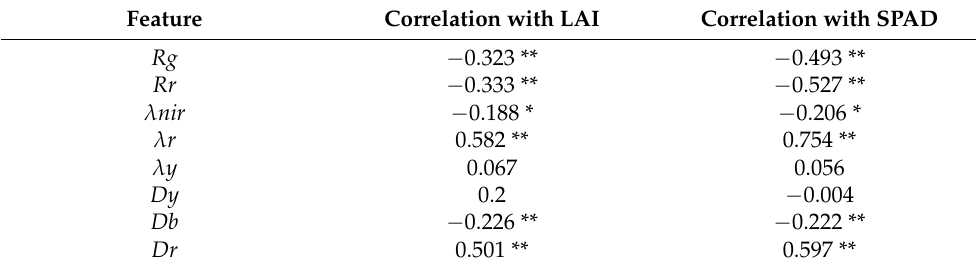
Table 3. Correlation between hyperspectral features and LAI and SPAD. Feature Correlation with LAI Correlation with SPAD Rg − 0.323